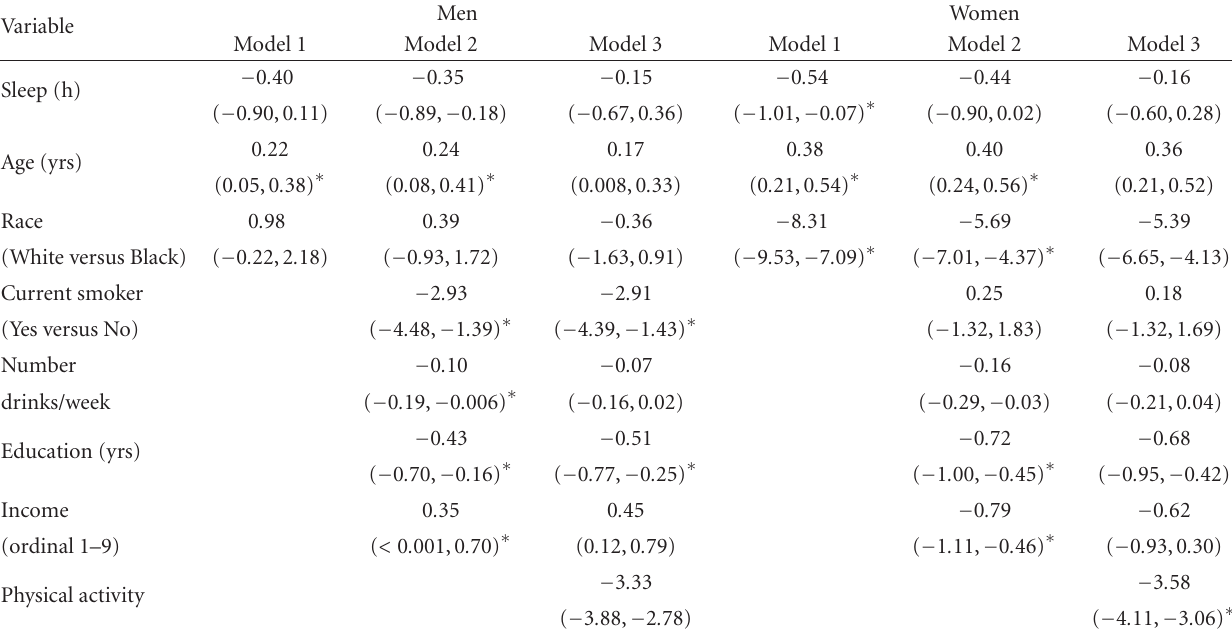
Table 4: Multivariate models for predictors of waist circumference in the CARDIA study stratified by gender ( β ,95% CI) 1 .